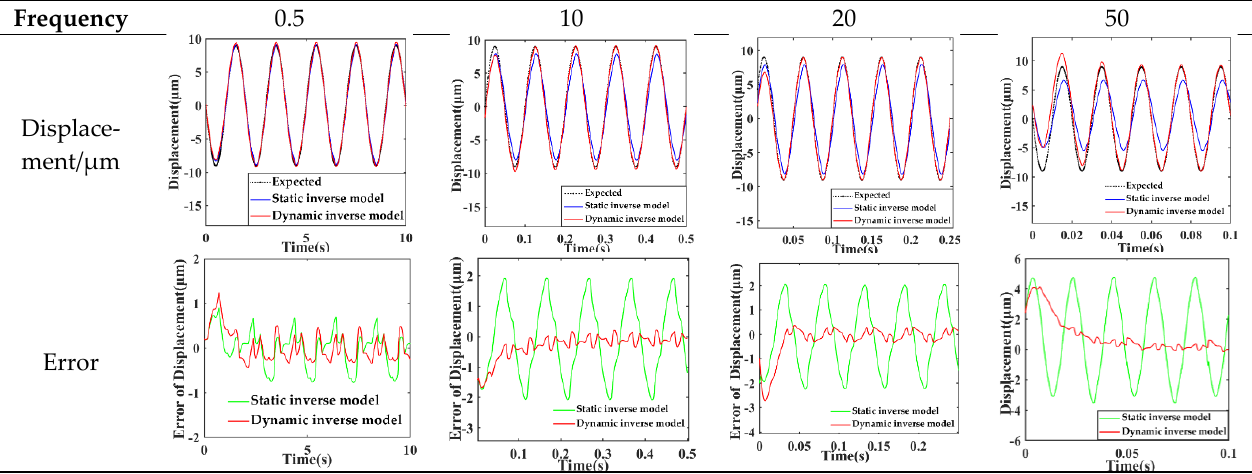
Figure 7. The error between output displacement and ideal output displacement. Table 3. Errors of the hysteresis inverse model under different excitation signal frequencies. Frequency of Input Errors